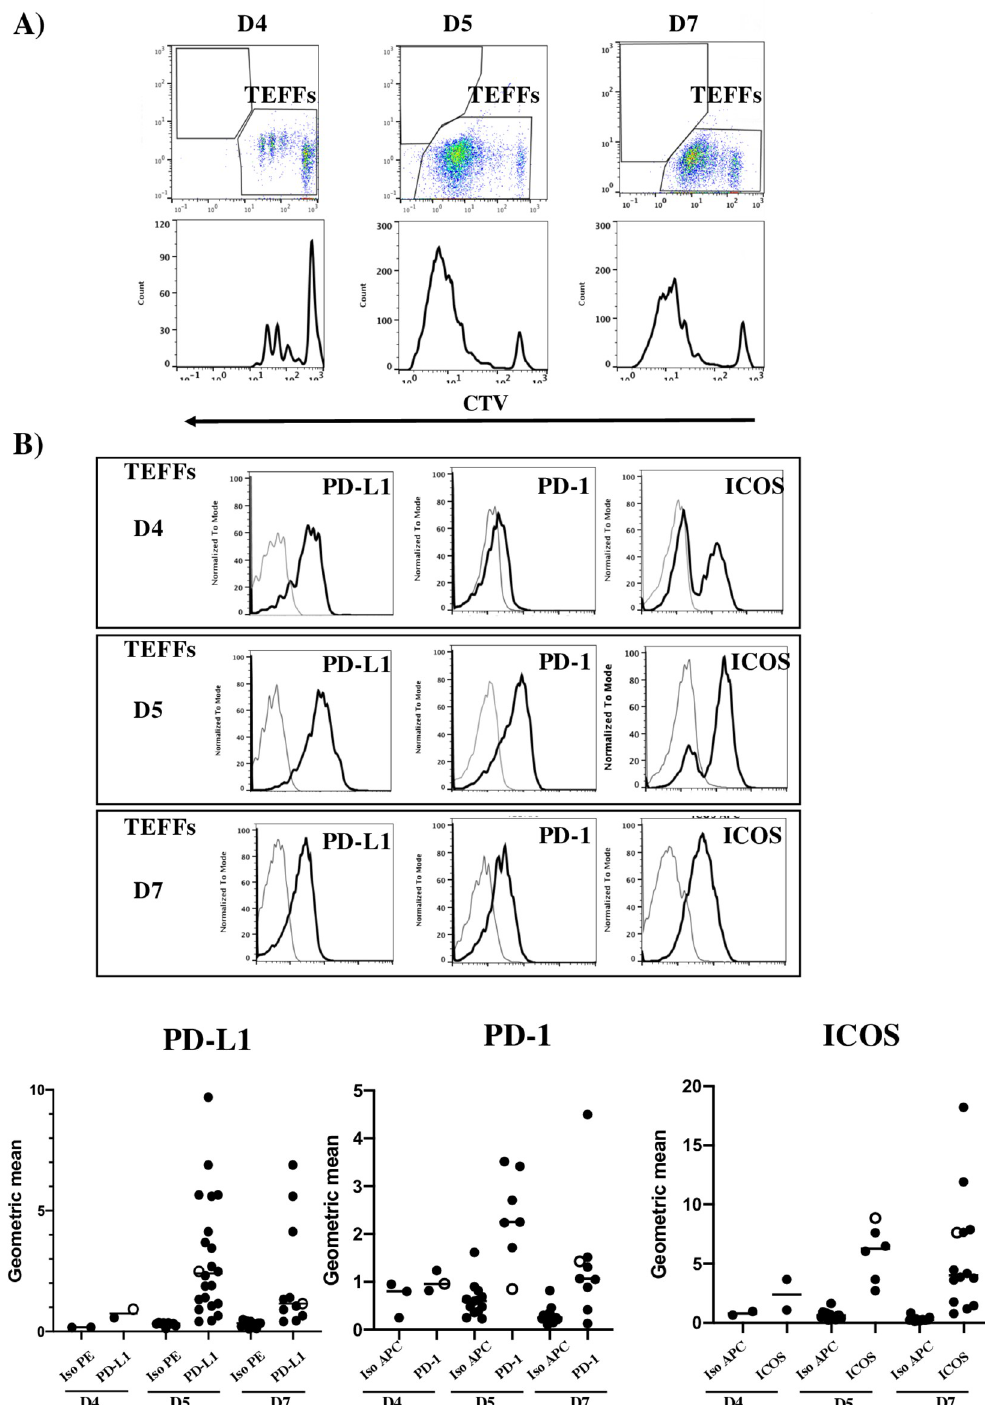
Fig 1. PD-L1 expression on activated naive TEFFs. A) Representative flow cytometry dot plots and histograms for the proliferation of CTV-stained TEFFs on D4, D5 and D7 of the co-culture. B) Upper panels: representative histograms of PD-L1, PD-1 and ICOS on the gated CTV-positive cells at the different culture time points. Lower panels: graphs of the geometric mean fluorescence intensity of the respective markers in independent experiments (n = 2 to 10). For each receptor, the specific conjugated isotype control (grey solid lines) is shown (Iso PE or Iso APC). Each black dot represents an experiment, and the open circles represent data from the same experiment. Bars represent the means of all experiments for each